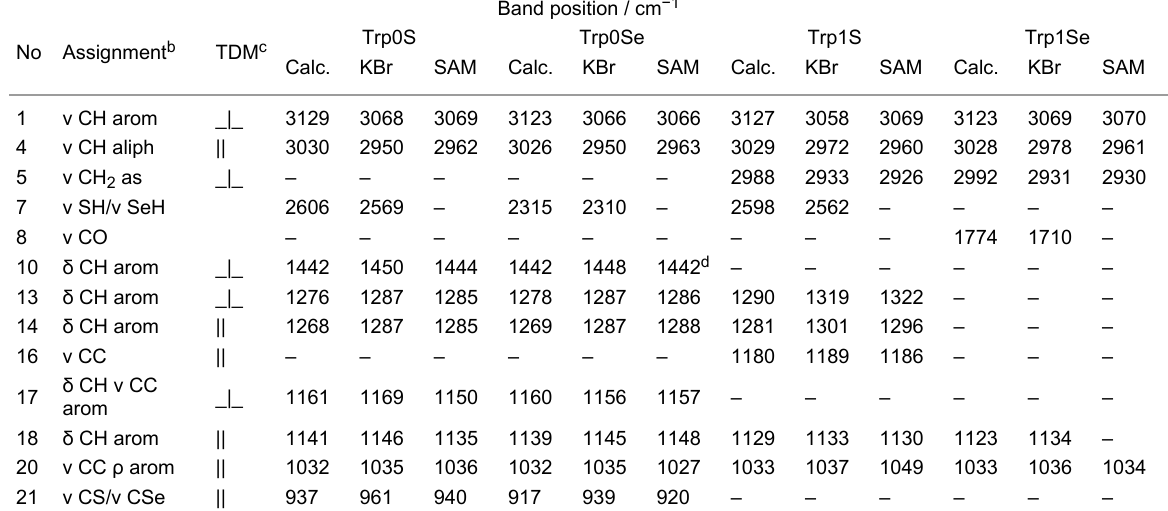
Table 1: Assignment of some bands obtained from the calculated, KBr pellet and SAM IR spectra of triptycene-terminated species along with the ori- entation of their transition dipole moments (TDMs) relative to the main molecular axis as deduced from the calculations. a Band position / cm − 1